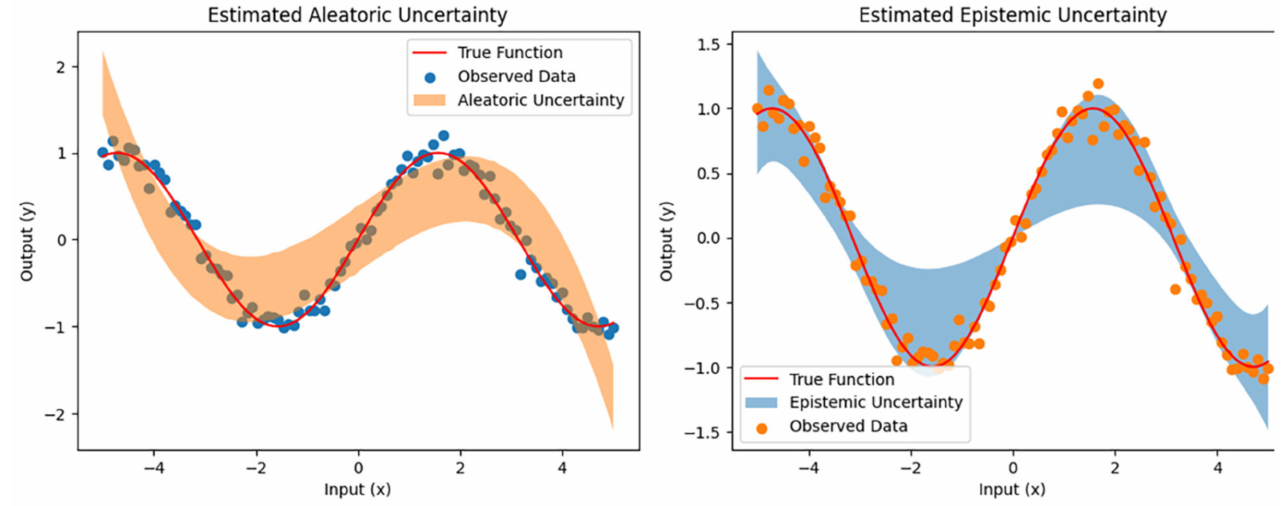
Figure 8. Distribution of estimated aleatoric